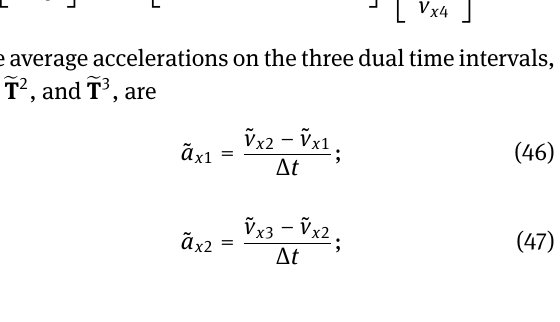
Figure 14: Relationship between dual cell complexes in space and